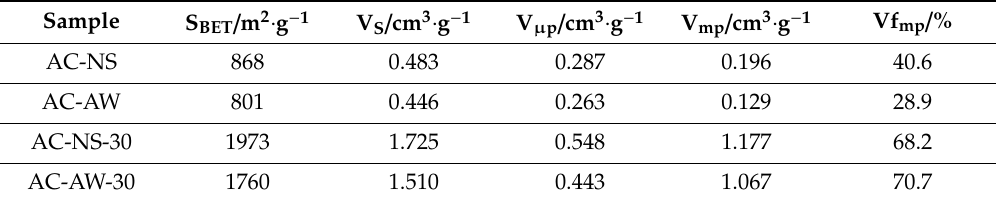
Figure 1. The adsorption–desorption N 2 isotherms at 77 K for the studied activated carbons. Table 1. Textural parameters of activated carbons calculated from nitrogen adsorption–desorption isotherms.